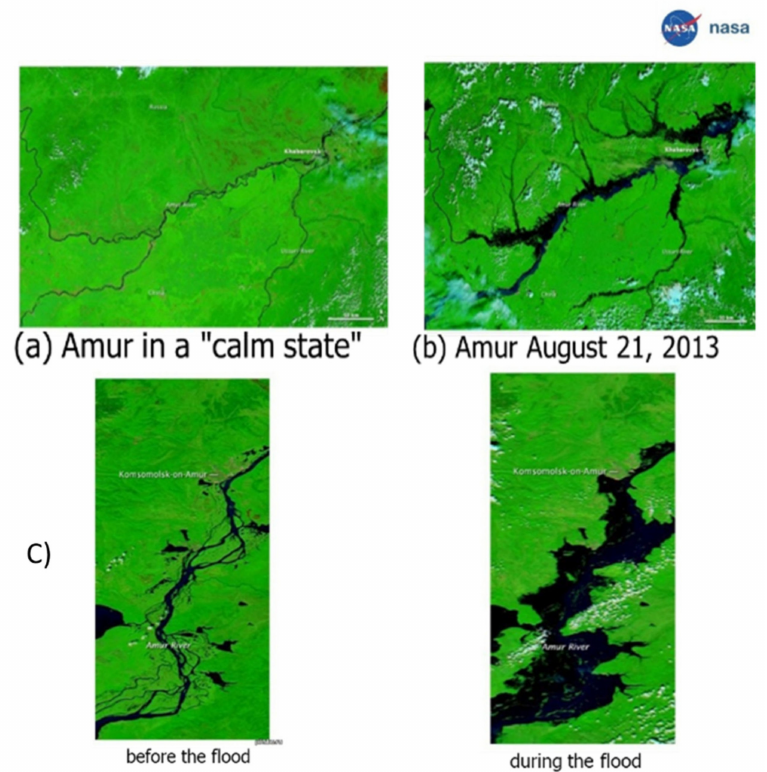
Figure 3. Collection of space images (NASA). Flood inundation areas versus the hydrological situation during calm times: ( a ) before the flood; ( b ) during the flood; ( c ) in the Komsomolsk-on-Amur city area (Russia). The pictures were simultaneously obtained for some surface water states, but show irregular distribution for opening the transport waterways for groundwater over a large area along the “activated” parts of the 3D river-drainage